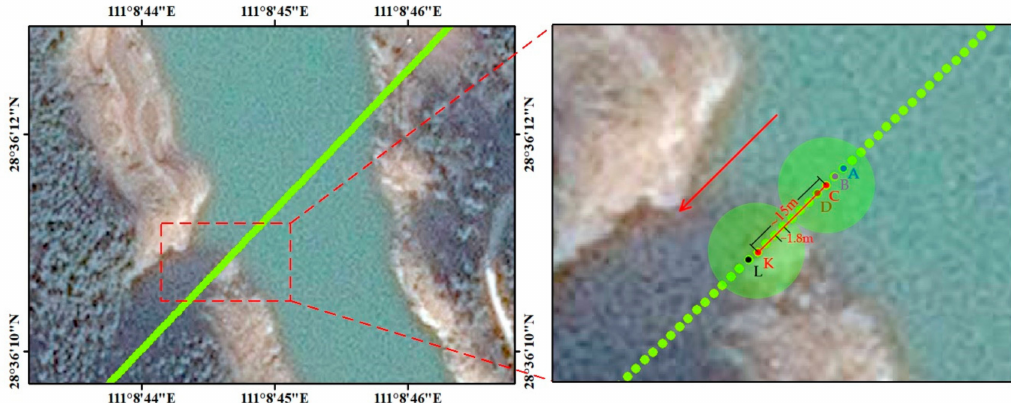
Figure 6. Schematic of laser spot locations at the intersection between water and land. The red arrow indicates the landward direction.